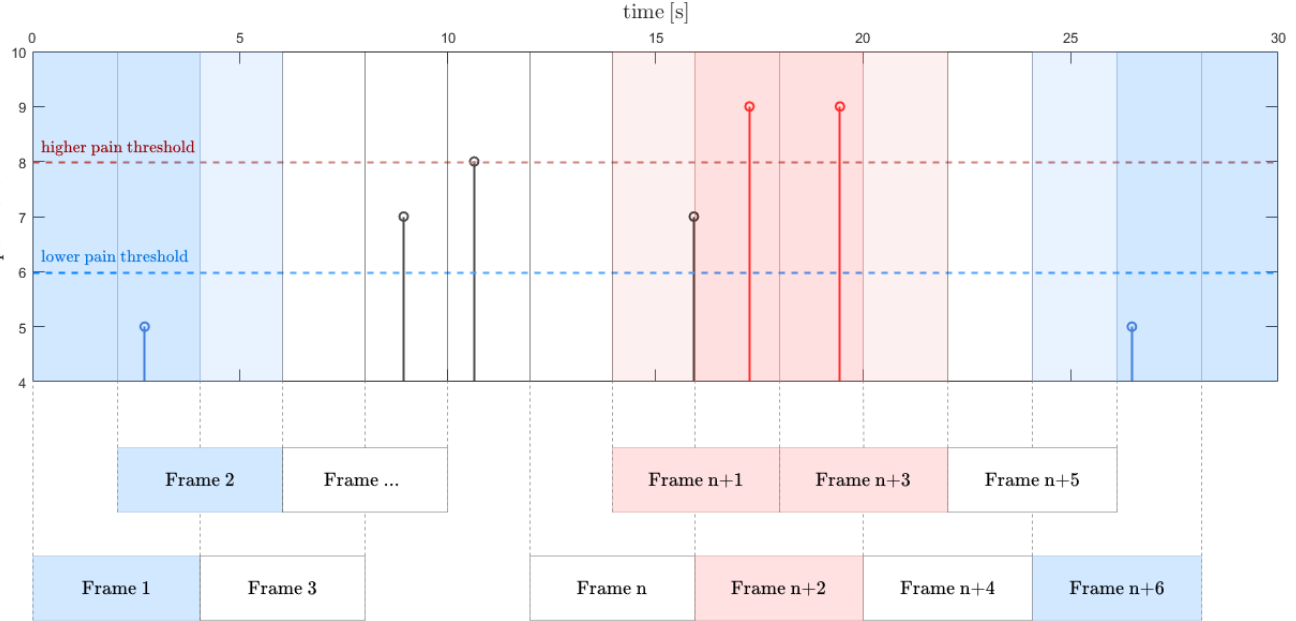
Figure 4. Frame labeling rule. No-pain , moderate pain , and severe pain intervals are indicated by two pain thresholds. If several values occurred, the highest is taken into